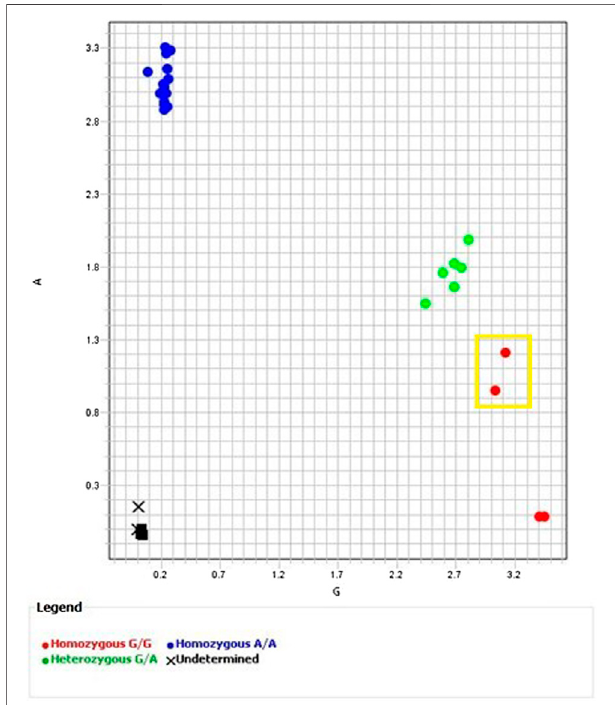
FIGURE 1 | Allelic Discrimination Plot for ANPRV67 (rs10484555) Black “ X ” s represent sample 755, which failed to amplify. Axes indicate relative fl uorescence of VIC ( x -axis) and FAM ( y -axis) dyes. Sample NA17019 surrounded by the yellow box. Though software assigned a homozygous G/G call, the position on the allelic discrimination plot and multicomponent plot ( Figure 2 (A) ) clearly indicate a heterozygous G/A call.